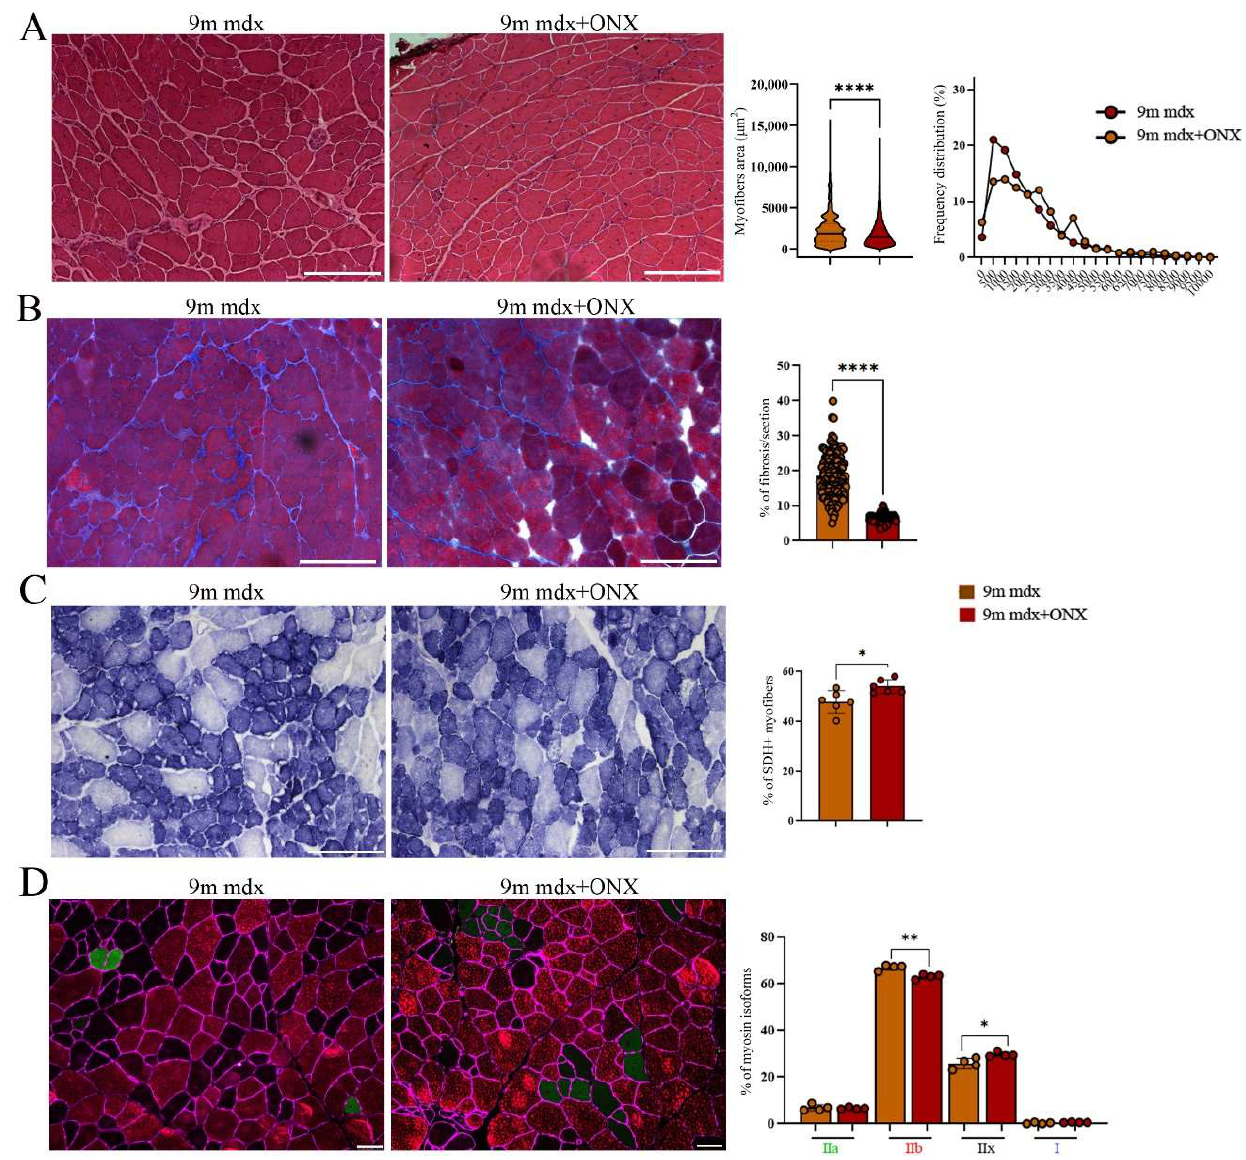
Figure 1. Histological and immunofluorescence analysis of tibialis anterior section of 9m mdx and 9m mdx+ONX mice. ( A ) Representative H&E staining and quantification of myofiber area and relative frequency of myofiber cross-sectional areas (CSA) expressed as frequency distribution of TA muscles of 9m mdx and 9m mdx+ONX mice (n = 10 images for animal group). Scale bar: 200 µ m. ( B ) Quantification of fibrotic area in TA muscles of 9m mdx and 9m mdx+ONX mice ( n = 10 images for animal group). ( C ) Representative SDH staining and quantification of percentage of SDH+ myofibers in TA of 9m mdx and 9m mdx+ONX mice ( n = 3 for all groups). Scale bar: 200 µ m. ( D ) Representative images of immunofluorescent staining showing distribution of myosin heavy chain (MyHC) isoforms (Type I, Type IIa, Type IIx and Type IIb) ( n = 8 images were analyzed for each mouse). Graph portrays the percentage of myofibers expressing different MyHC isoforms. Scale bar: 50 µ m. For morphometric analysis, images were quantified with Image J software. (* p < 0.05, ** p <0.01, **** p < 0.0001, with unpaired t -test).